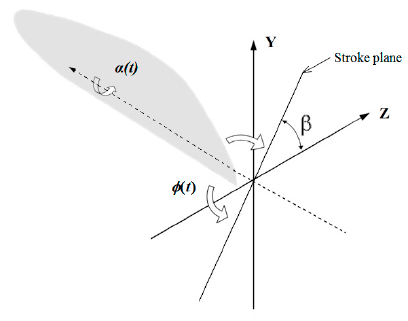
Figure 2. Simplified geometric model of the dragonfly hindwing.